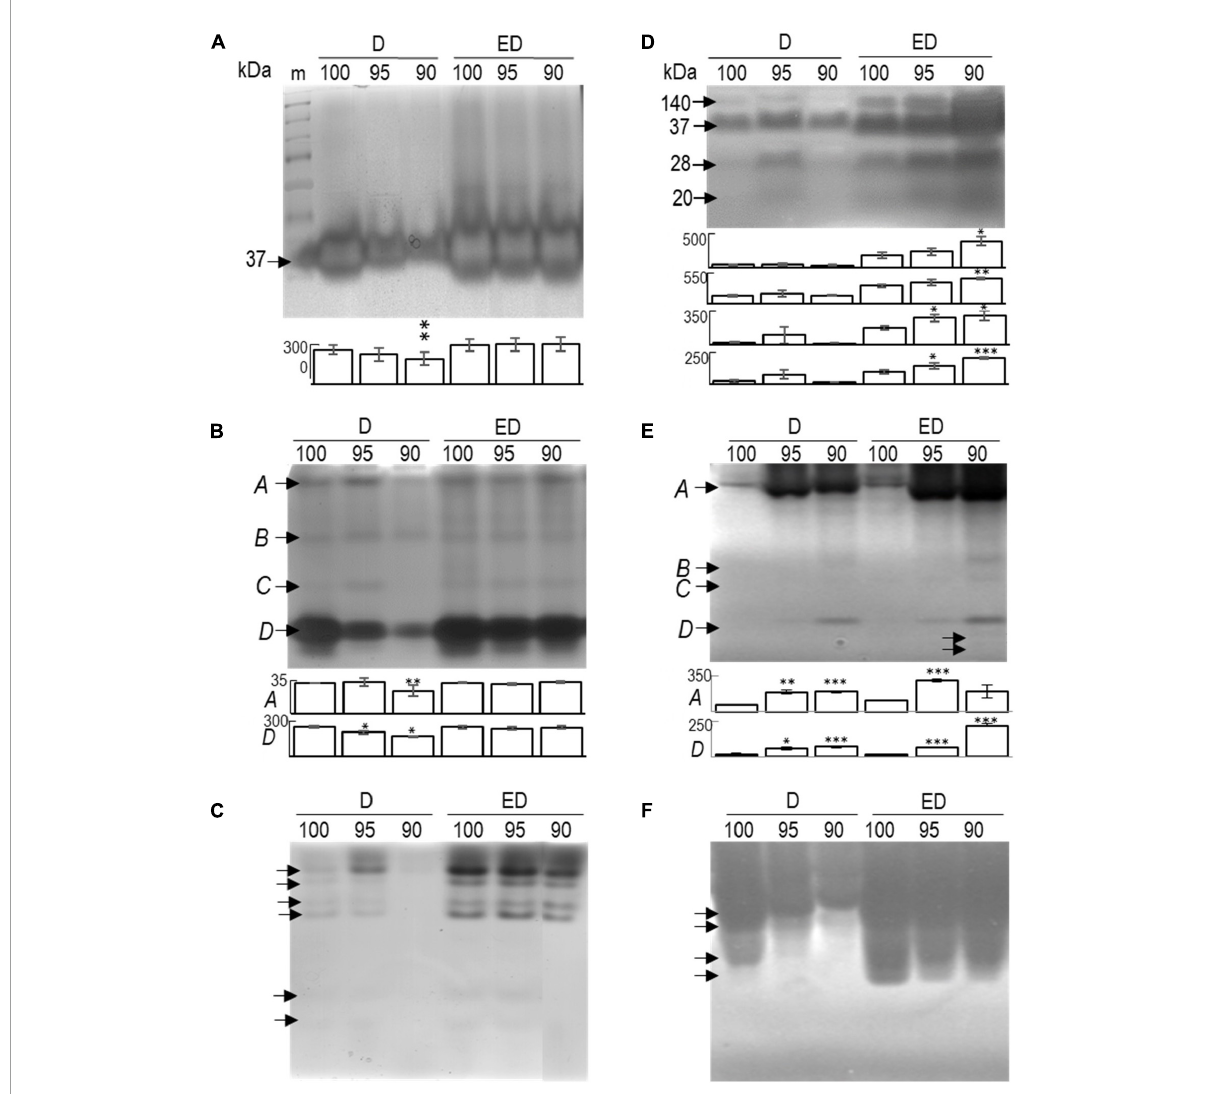
FIGURE8 Separation and in-gel detection of β -1,3-glucanases (A–C) and chitinases (D–F) in mature embryos (M), control embryos at half (D100), and at the end (ED100) of treatment with 100% relative humidity, and embryos exposed to 95 and 90% relative humidity during the first half of desiccation (D95 and D90) and subsequently transferred to 100% humidity (ED95 and ED90). The overall profiles of total β -1,3-glucanases (A) and chitinases (D) after separation in SDS-PAGE with specific enzyme substrates and separation of acidic/neutral (B,E) and basic/neutral (C,F) isoforms of β -1,3-glucanases and chitinases. The activity values of the isoforms that were significantly affected by the applied conditions (compared with the corresponding control variants) are indicated in the graphs below the gel images (from top to bottom). * P < 0.05; ** P < 0.01; and *** P < 0.001. Data represent the means ± standard deviations. m, molecular